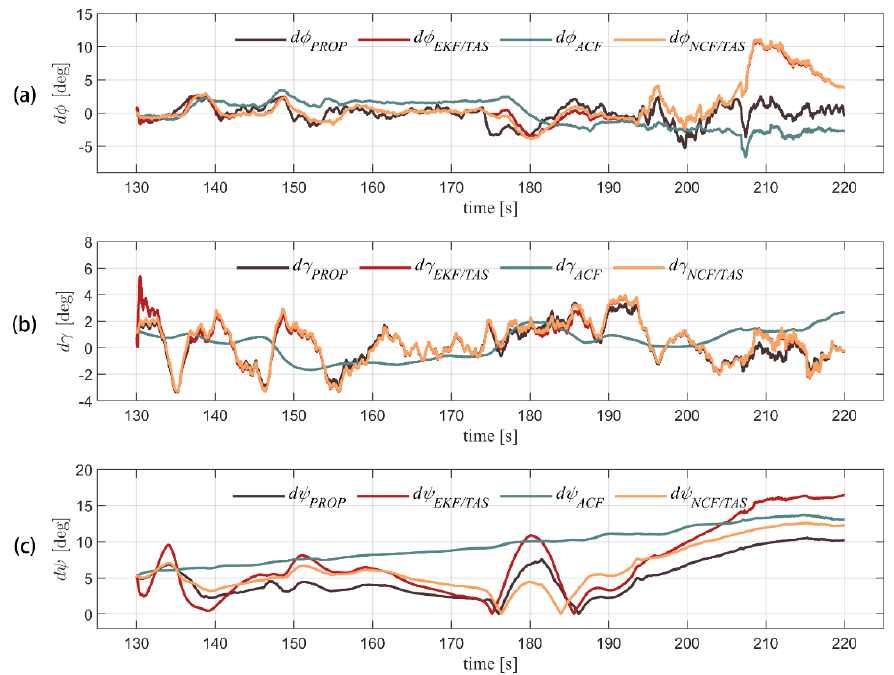
Figure 6. Three-axis attitude solution of five algorithms in flight is shown for pitch, roll, and yaw angle (from ( a – c ), respectively).